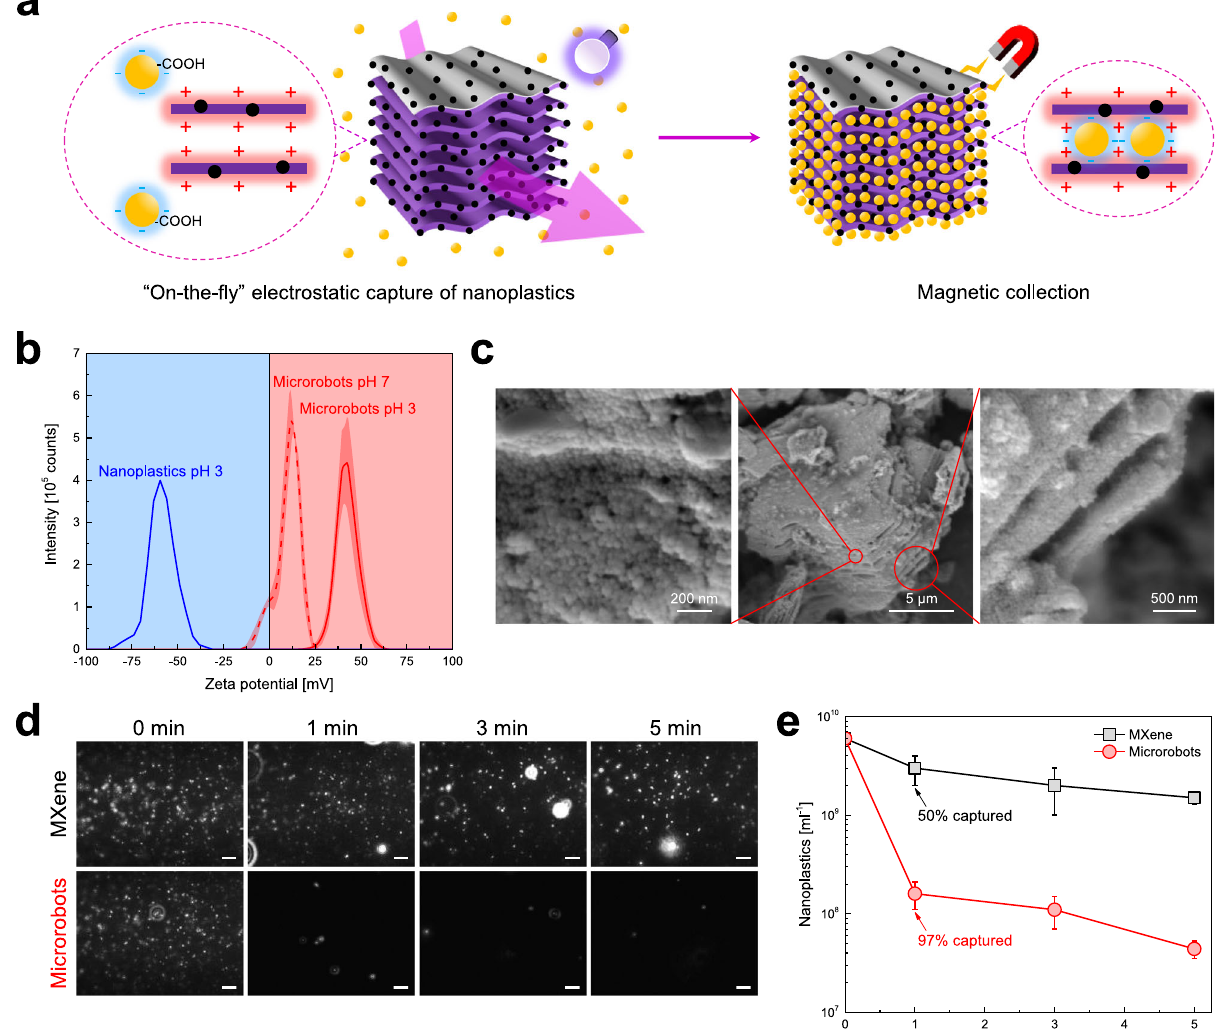
Fig. 6 Nanoplastics ’ capture by MXene-derived γ -Fe 2 O 3 /Pt/TiO 2 microrobots. a Scheme of the nanoplastics ’ remediation strategy: nanoplastics are electrostatically collected by the self-propelled light-powered MXene-derived γ -Fe 2 O 3 /Pt/TiO 2 microrobots and magnetically removed from the treated water using a magnetic fi eld. b Zeta potential ofthe MXene-derived γ -Fe 2 O 3 /Pt/TiO 2 microrobots (thermalannealing condition:0 min at550 °C) and nanoplastics in water at various pH. The shaded regions replace the discrete error bars calculated as the standard error for n = 3 independent replicates. c SEM images of an MXene-derived γ -Fe 2 O 3 /Pt/TiO 2 microrobot (thermal annealing condition: 0min at 550 °C) after exposure to the nanoplastics suspension (capture neodymium magnet). d Frames of the videos of nanoplastics' suspensions after the treatments with the γ -Fe 2 O 3 /Ti 3 C 2 T x MXene microparticles and MXene- derived γ -Fe 2 O 3 /Pt/TiO 2 microrobots for different durations (1, 3, and 5min) under UV-light irradiation (capture experiments conditions: 0.75mgml − 1 sample, 6 × 10 9 nanoplastics ml − 1 , water at pH 3, samples ’ collection using a neodymium magnet), and e the corresponding nanoplastics ’ concentration values obtained by NTA. Scale bars are 10 μ m. Error bars represent the standard deviation, n = 3 independent